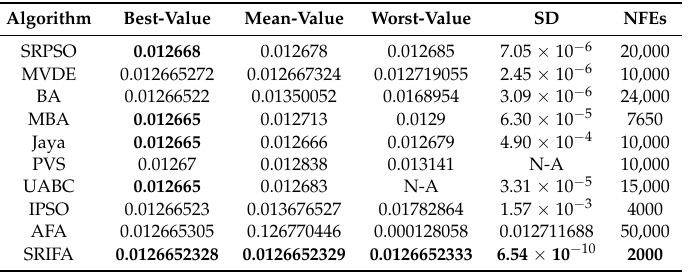
Table 11. Statistical results of comparison between SRIFA and NIAs for tension/compression spring design